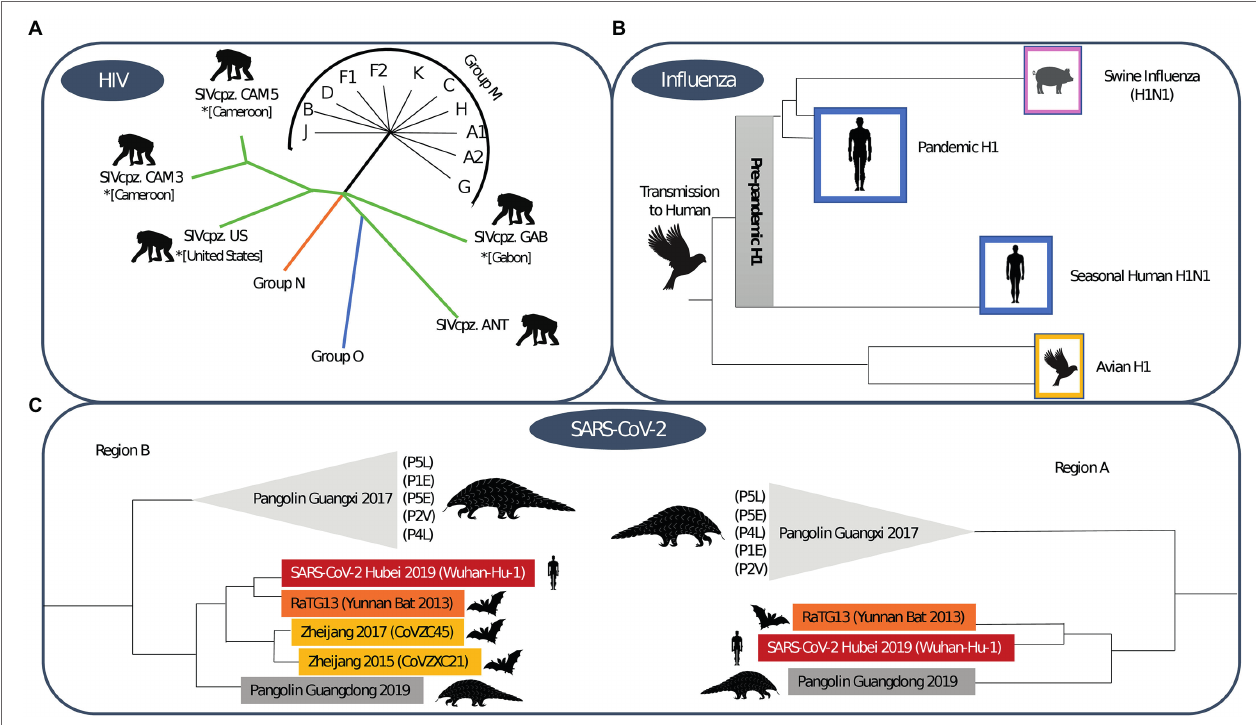
FIGURE 4 | Phylogenetic trees for (A) HIV-1, (B) Influenza and (C) SARS-CoV-2. The HIV-1 phylogenetic tree shows sequences that demonstrate the zoonotic jump of the distinct HIV-1 groups (Thomson et al., 2002). The influenza phylogenetic tree was based on the H1 subtype, the initial origin of the 1918 pandemic and the post-pandemic spread through human and animal species (Xu et al., 2008). The SARS-CoV-2 phylogenetic tree shows the origin of sarbecovirus and is based on distinct regions, where region A is shorter due to the potential of recombination of the genome region and region B is wider (Boni et al.,